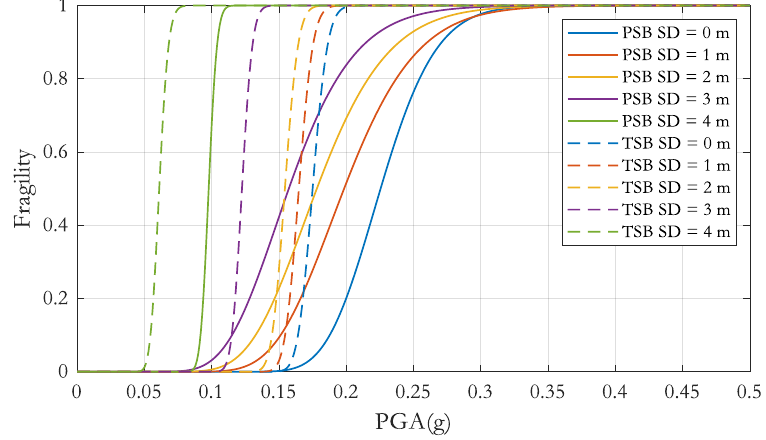
Figure 19. Comparison of seismic fragility curves.